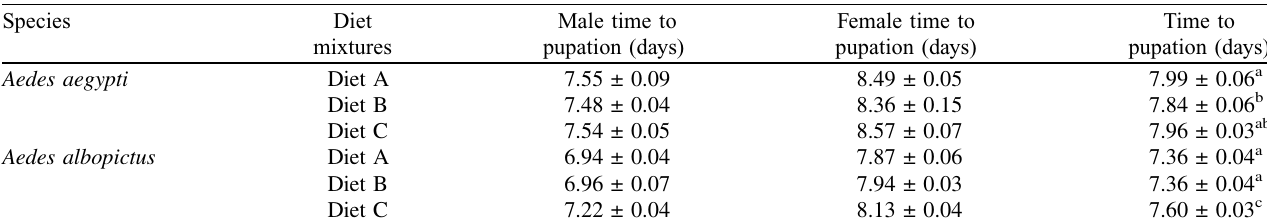
Table 1. Time to pupation of Aedes aegypti and Aedes albopictus reared with different larval mixtures. Species